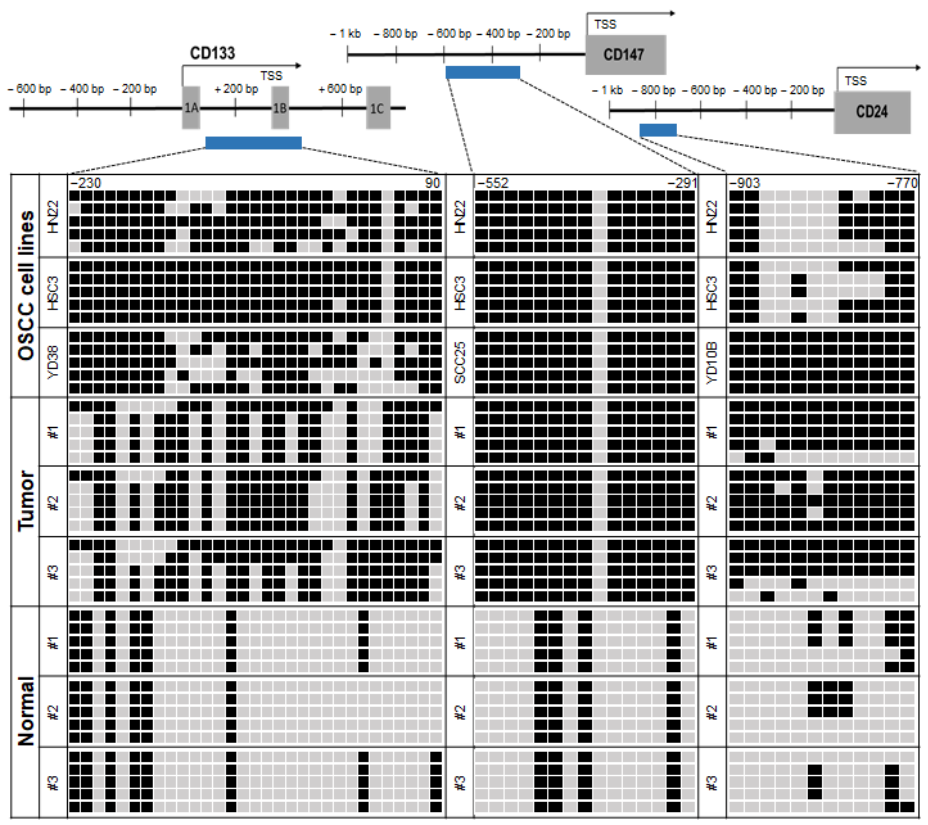
Figure 3. Representative bisulfite sequencing results of the CpG islands in the CD24 , CD133 , and CD147 gene promoter regions in OSCC cell lines, primary OSCC tumors ( n = 3), and normal oral mucosal tissues ( n = 3). The locations of the CpG sites ( CD24 : upstream region from − 903 to − 770; CD133: exon 1 region from − 230 to +90 [9]; and CD147: upstream region from − 552 to − 291) relative to the transcription start sites (TSSs) of exon 1 are shown. Each box represents a CpG dinucleotide. The black boxes represent methylated cytosines, and the white boxes represent unmethylated cyto- sines.